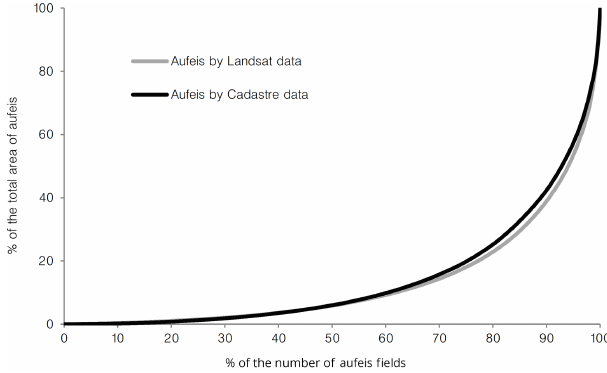
Figure 4. Lorenz curves illustrating aufeis area distribution accord- ing to the Cadastre and Landsat